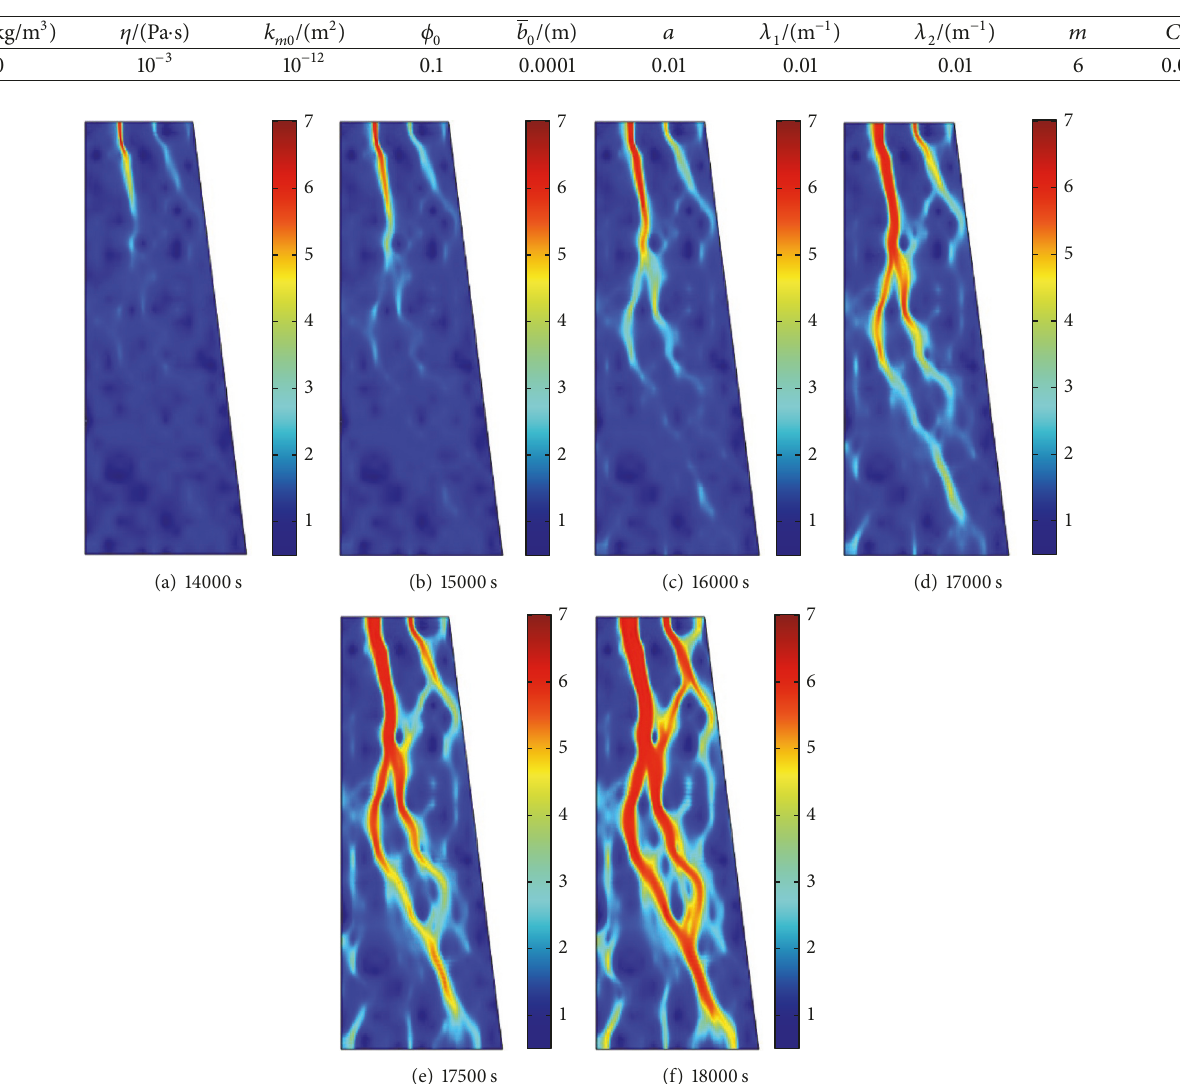
Table 1: Input parameters for the numerical simulation.